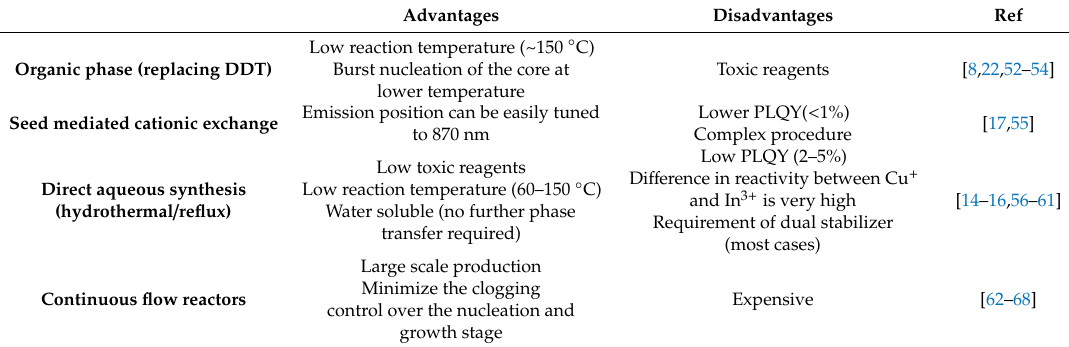
Table 1. The main synthetic strategies involved in the production of CuInS 2 (CIS)-based quantum dots